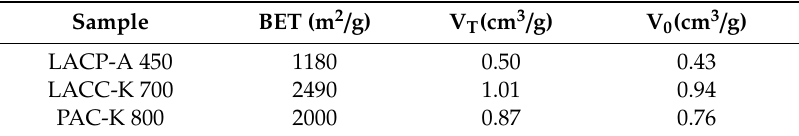
Table 1. Textural properties estimated from the N 2 adsorption data at − 196 ◦ C. Total pore volume (V T ) was estimated at p / p 0 ≈ 0.95 and the micropore volume (V 0 ) was estimated from the Dubinin–Radushkevich (DR)